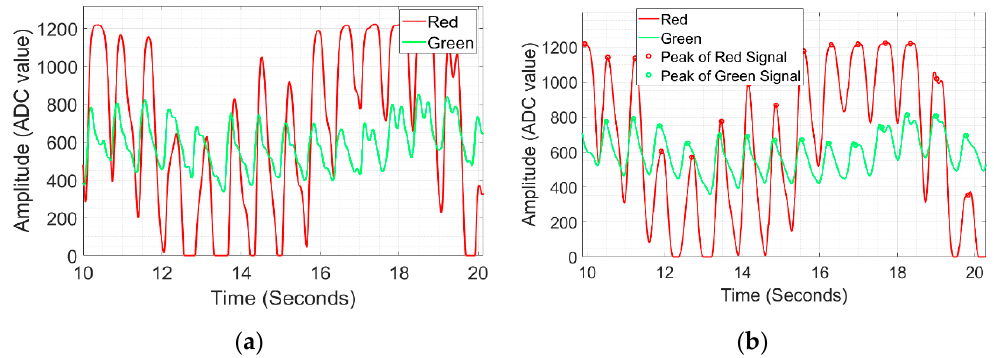
Figure 23. ( a ) Output of red and green PPG signals with the up ‐ down finger motion, ( b ) peak detection of the PPG signals.